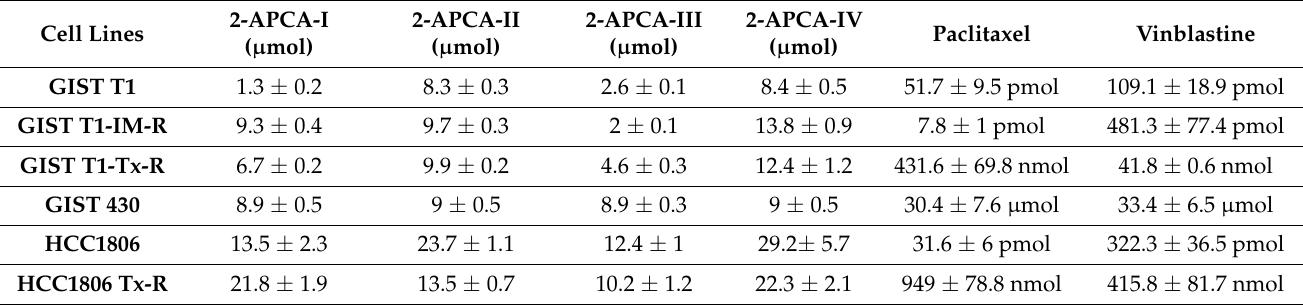
resistant HCC breast cancer and GIST T-1 cell lines, respectively. Thus, these data illustrate that 2-APCAs were evenly effective in sensitive and resistant cancer cell lines. Table 3. IC50 values for 2-APCAs (I-IV), paclitaxel, and vinblastine for cancer cells lines sensitive vs. resistant to imatinib mesylate (IM-R), or paclitaxel